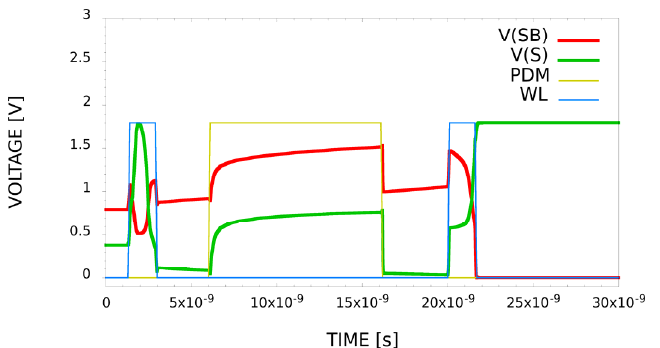
Figure 9. Simulation of an LPR test with bit-flip because of R2 effect.